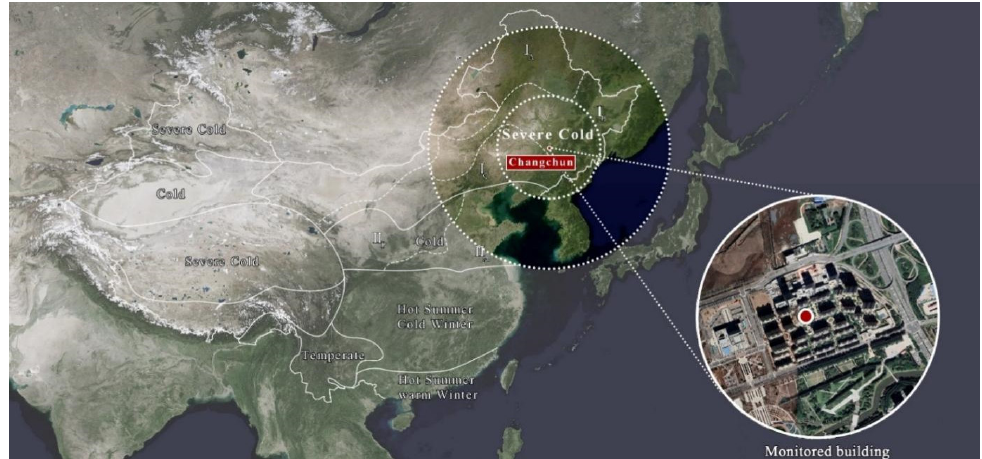
Figure 3. Chinese climate classification and the location of the monitored building. Table 2. Details of the residential building.